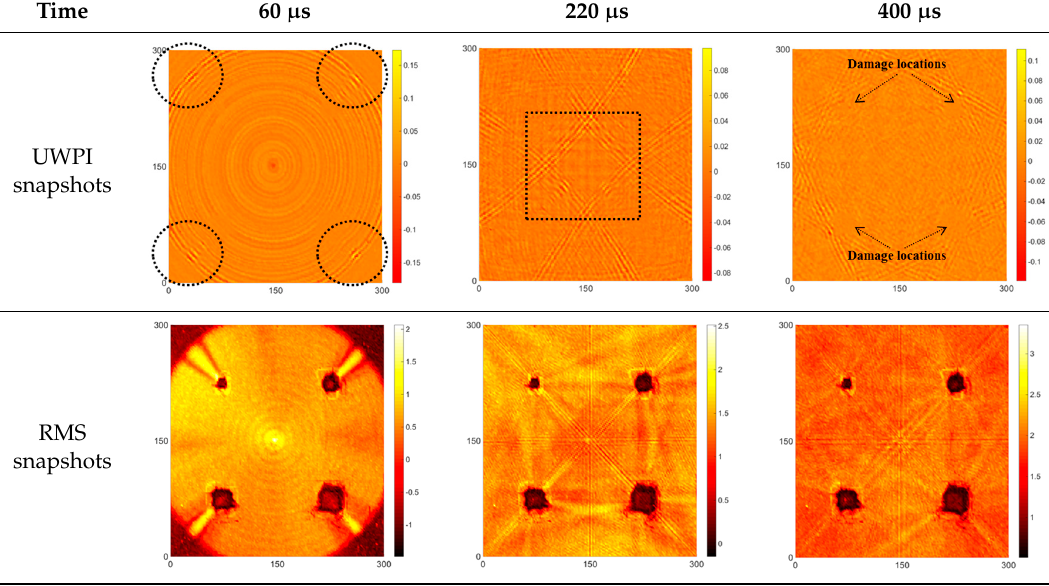
Table 9. UWPI and RMS snapshots of the back side of Specimen 2 at 60 μ s, 220 μ s and 400 μ s (the unit of x and y axis: mm).